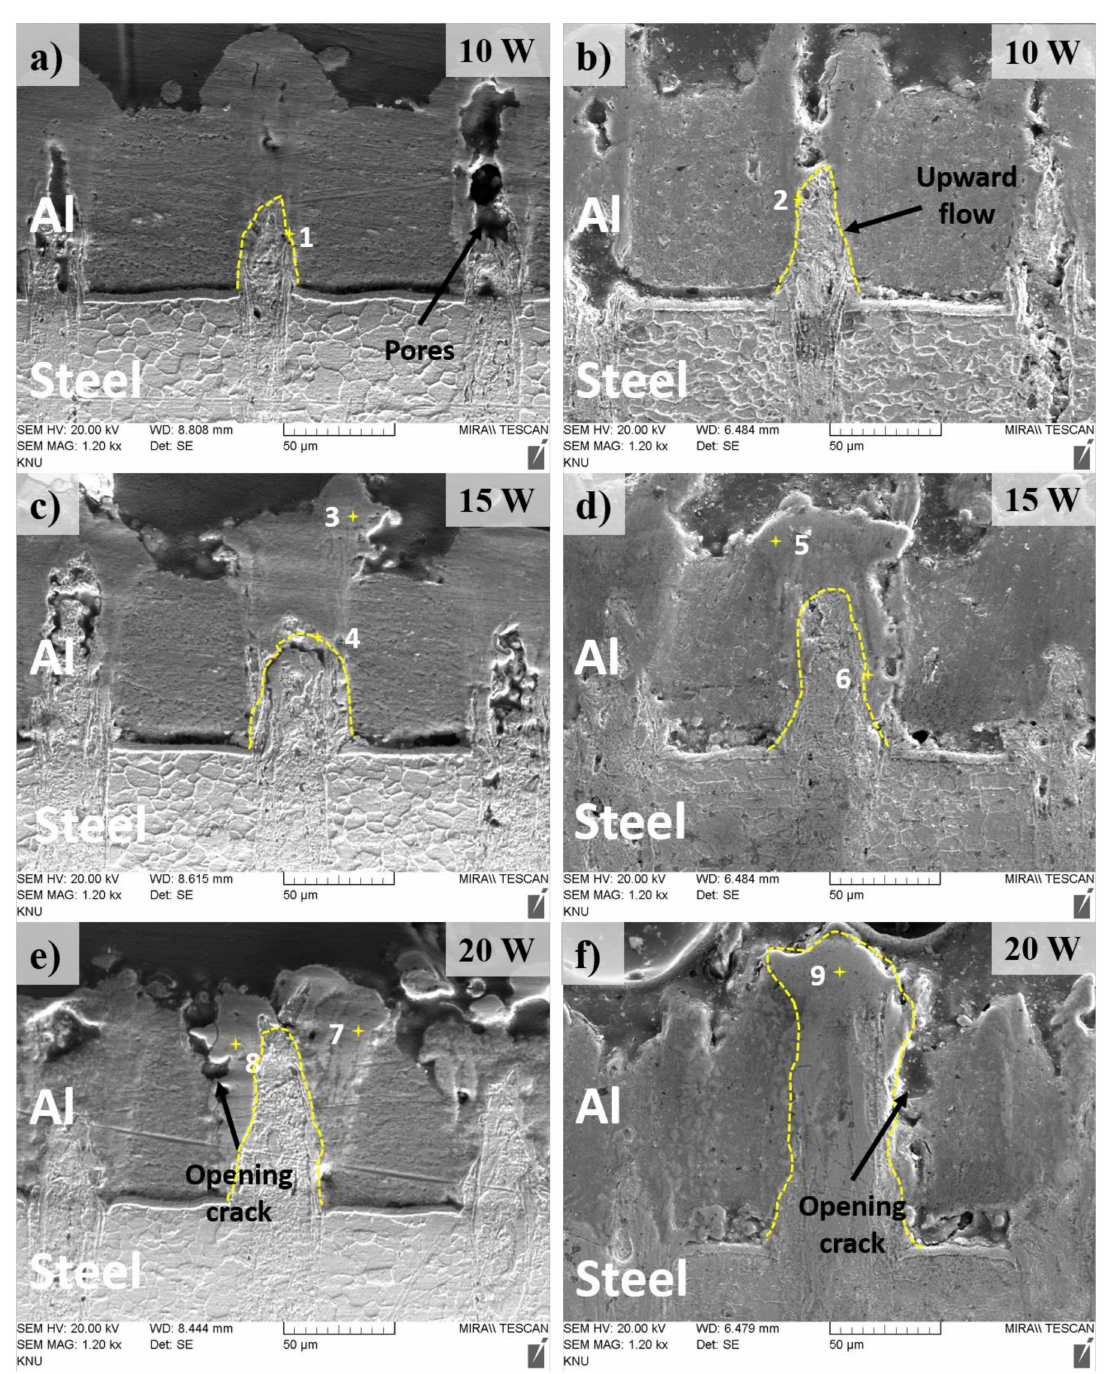
Figure 9. SEM images of the cross-section observation. ( a , c , e ) Weld using the metal tube; ( b , d , f ) Weld without the metal